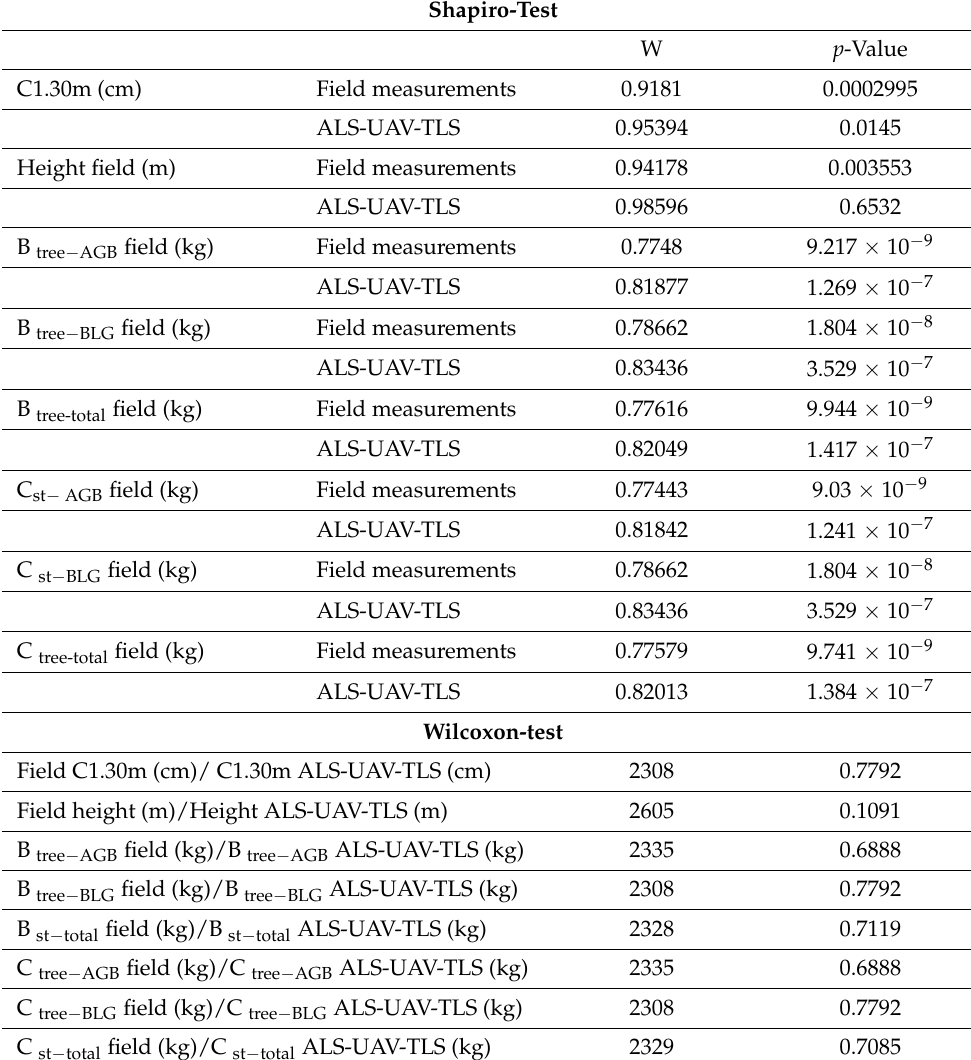
Table 4. Shapiro–Wilk test of dendrometric parameters (H, C1.30m), biomass, and carbon stock (aboveground, belowground, and total) measured and estimated with field data collection and from UAV-ALS-TLS data. Wilcoxon test between dendrometric parameters (H, C1.30m), biomass, and carbon stock (aboveground, belowground, and total) measured and estimated with field data collection and from UAV-ALS-TLS